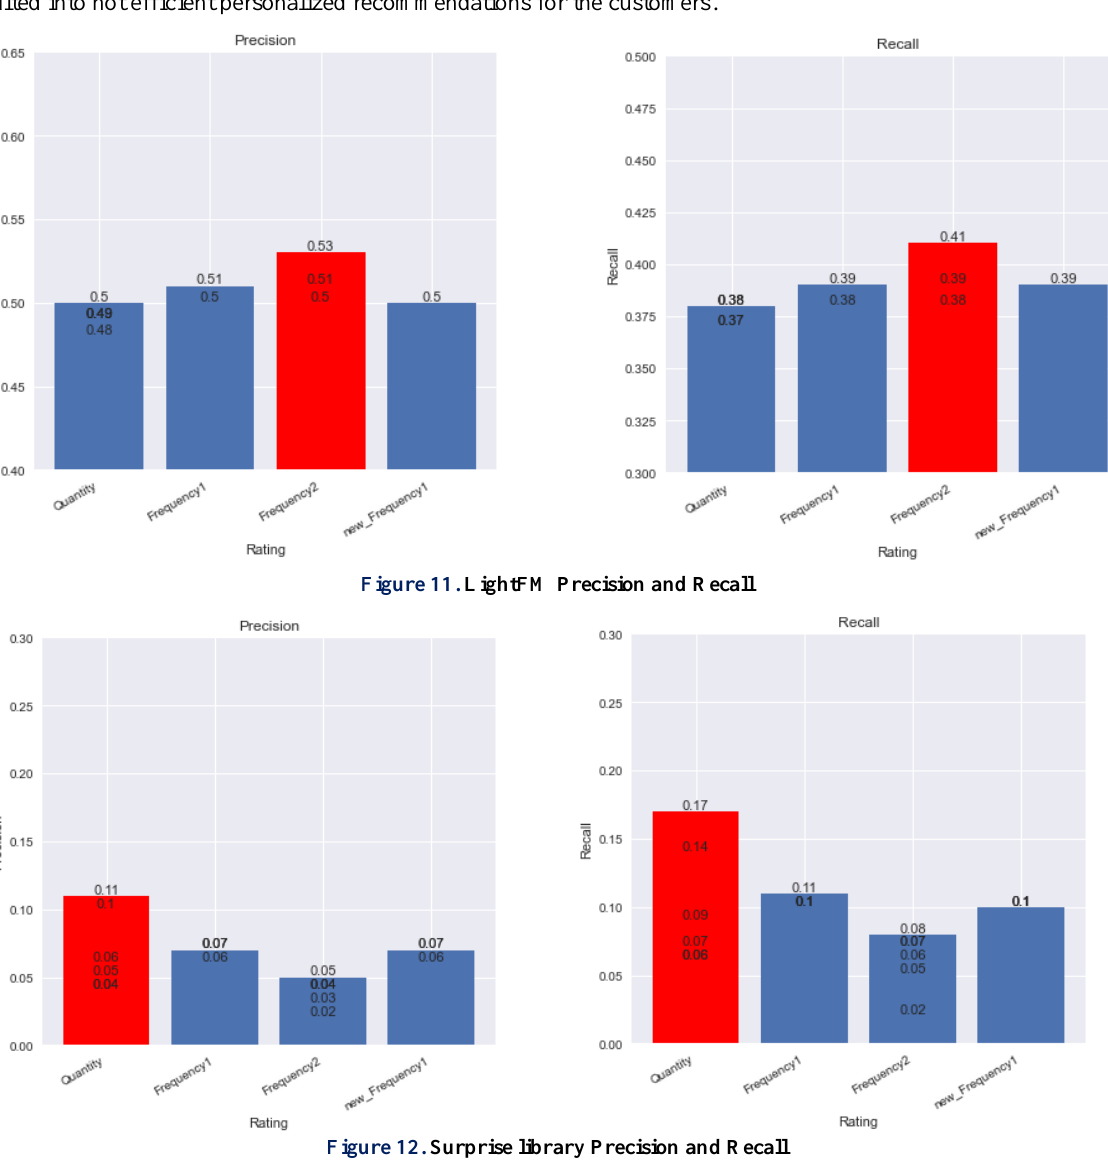
Figure 11. LightFM Precision and Recall